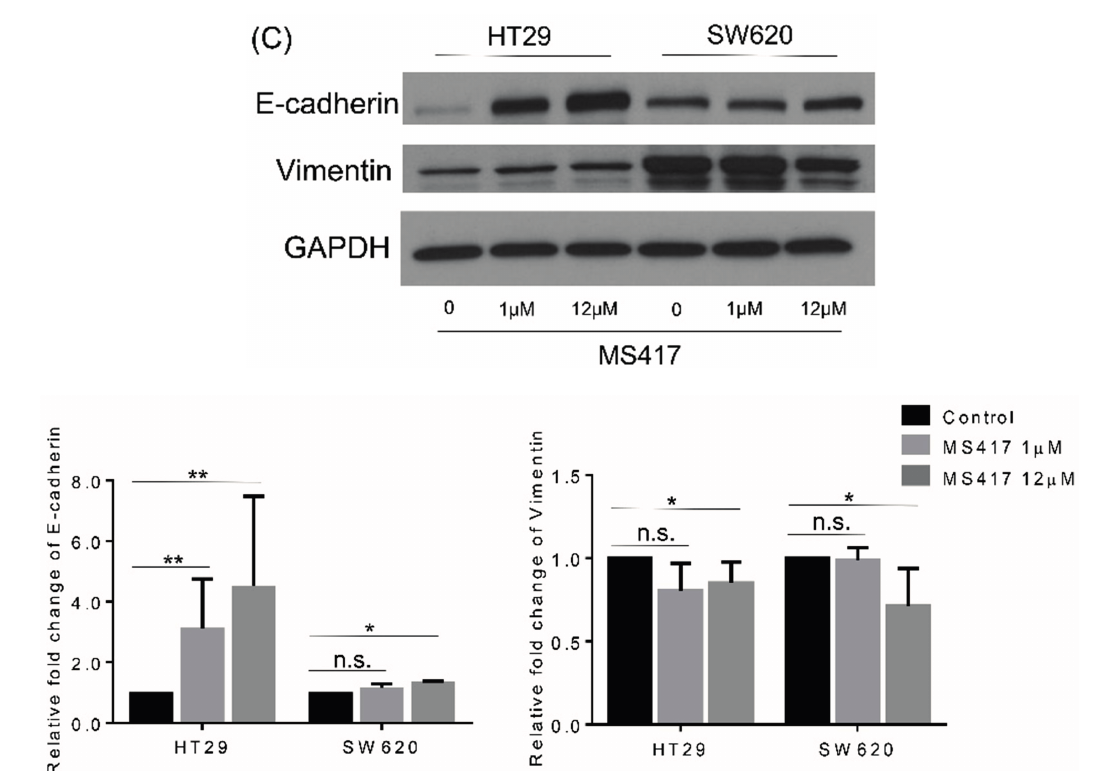
Figure 3. BRD4 inhibition impacts transcriptional programs that control cell proliferation and EMT. ( A ) Apoptosis of HT29 and SW620 cell lines treated with vehicle (DMSO), MS417 (1 µM) or MS417 (12 µM); ( B ) Protein levels of candidate apoptosis-related factors following vehicle/MS417 treatment (1 and 12 µM) for 48 h; ( C ) Protein levels of E-cadherin and Vimentin in HT29 or SW620 cell lines treated with vehicle or MS417 (1 and 12 µM). The expression level of each protein was normalized against GAPDH. * p < 0.01; ** p < 0.001; n.s. not